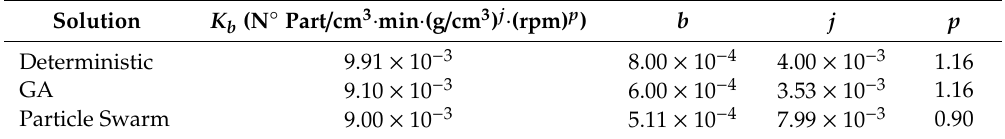
Table 6. Kinetic parameters of crystals nucleation rate.